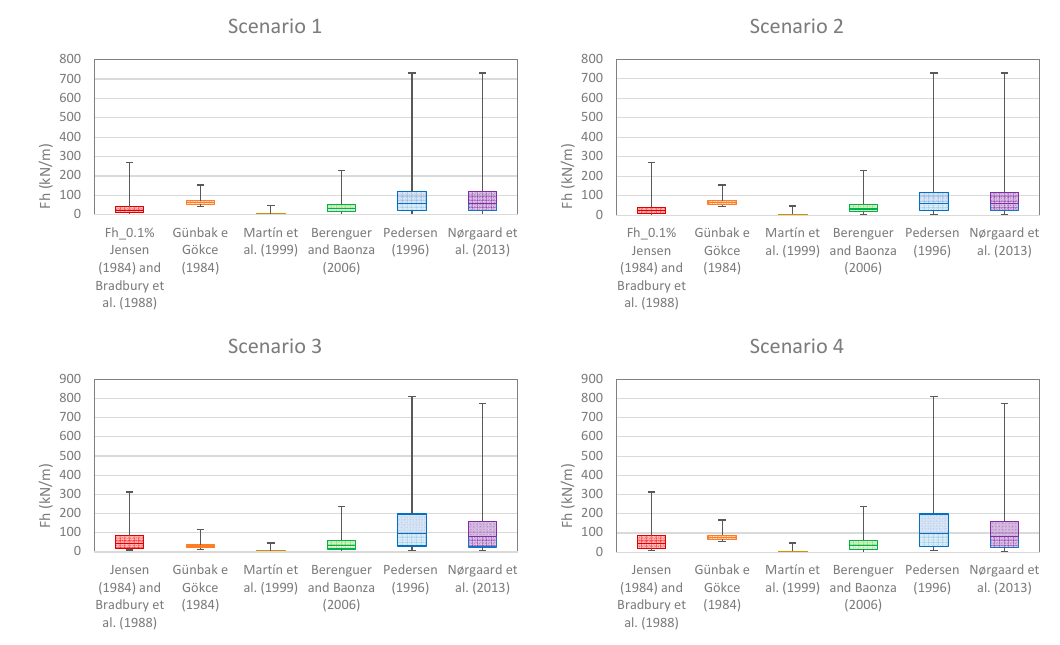
Figure 22. Results of F h for the different formulas for Scenario 1 to 4. Uplift pressure action values considerably change depending on the scenario in the case of Günbak and Gökce, but it is similar in the rest of the equations (Figure 23). On the other hand, uplift pressure action values from highest to lowest values are according to the next equations: Günbak and Gökce, followed by Pedersen and Nørgaard, and Mart í n. The trend is the same as in the horizontal pressure, for the same reasons already explained since the uplift pressure depends on the horizontal pressure in the base of the superstructure.